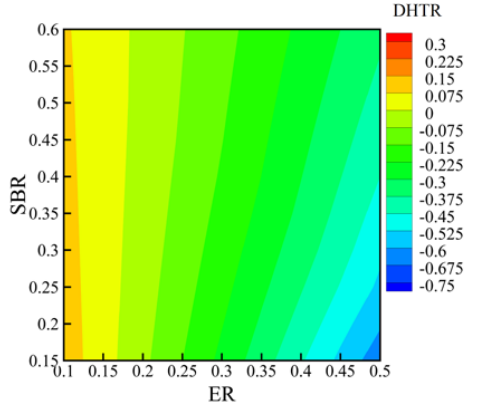
Figure 20. DHTR distribution at T = 950 K.